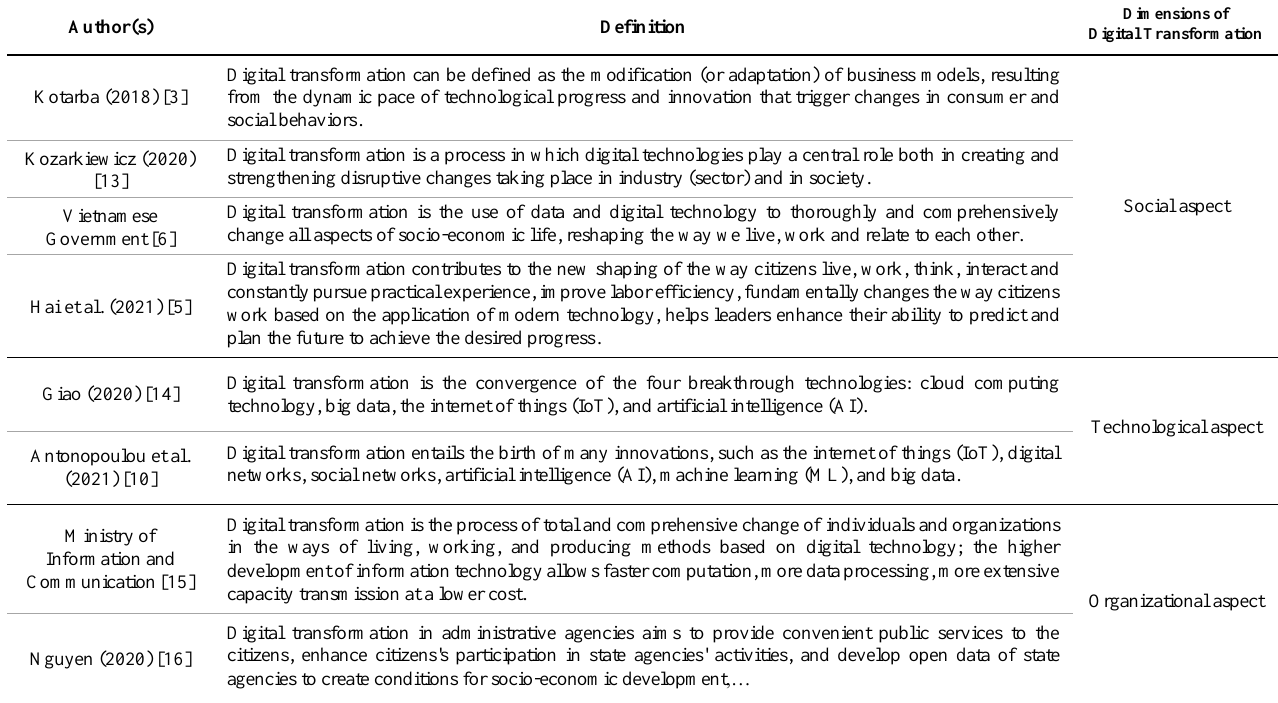
Table 1. Definitions on Digital Transformation (Compiled based on author's